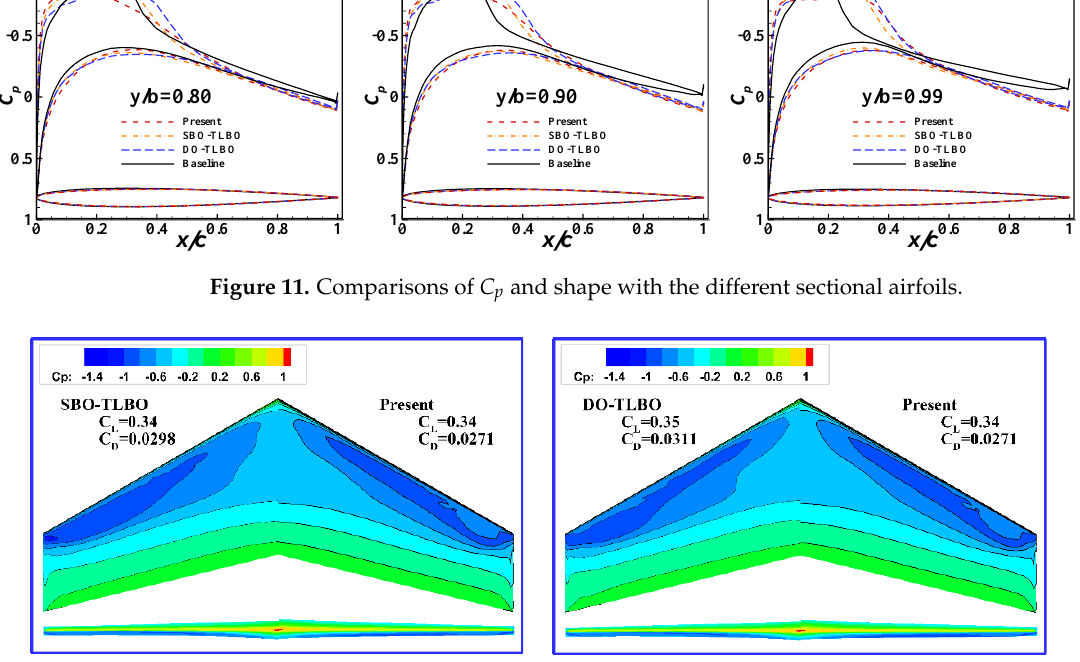
Figure 12. Surface pressure contours of a wing by present, DO, and SBO frameworks.